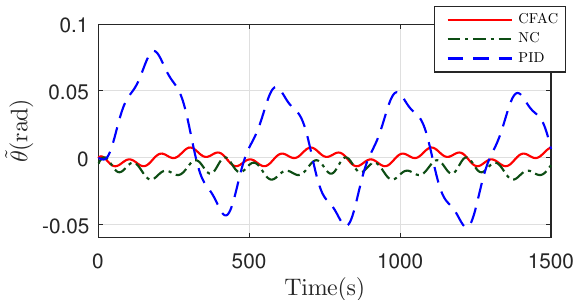
Figure 13. Pitch angle tracking error in submerging motion with a constant velocity and variable pitch angle